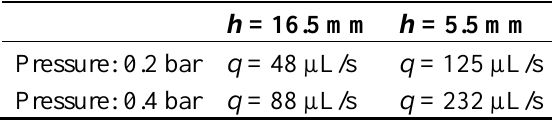
Table 4. Experimental evaluation of the flow rate q of water at different nozzle lengths h , and actuating